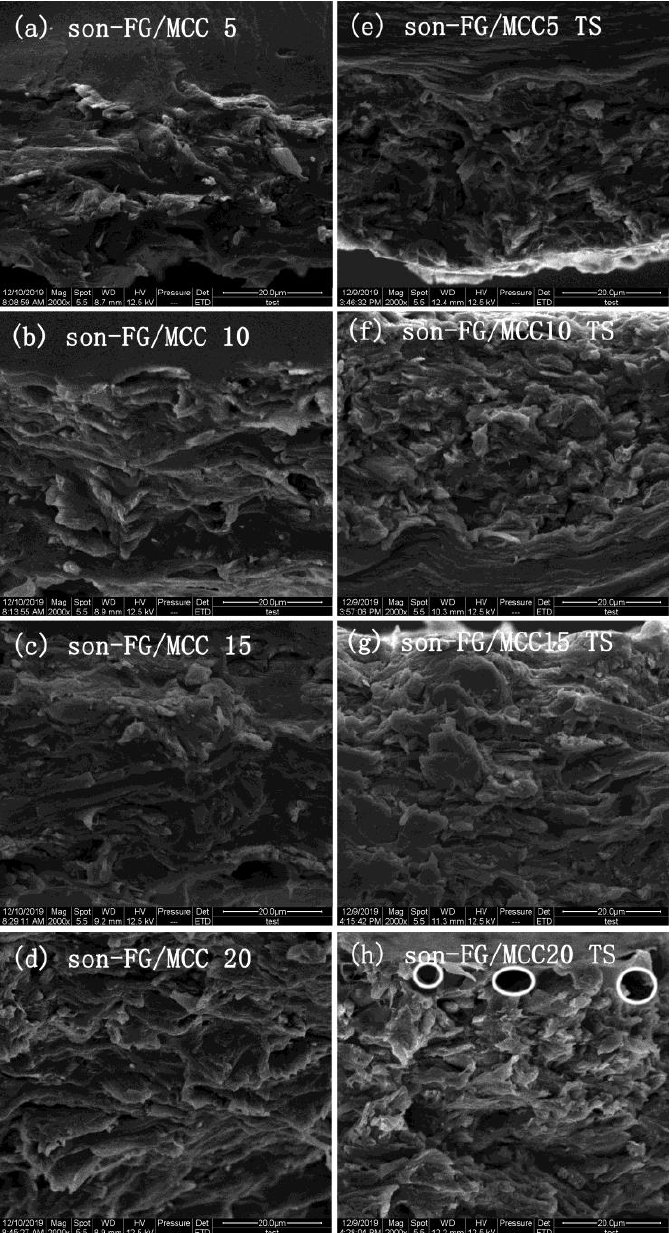
Figure 3. SEM images of the liquid nitrogen brittle section and tensile section (TS) of ( a ) son-FG / MCC 5, ( b ) son-FG / MCC 10, ( c ) son-FG / MCC 15, ( d ) son-FG / MCC 20, ( e ) son-FG / MCC 5 TS ( f ) son-FG / MCC 10 TS, ( g ) son-FG / MCC 15 TS and ( h ) son-FG / MCC 20 TS treated by ultrasound.